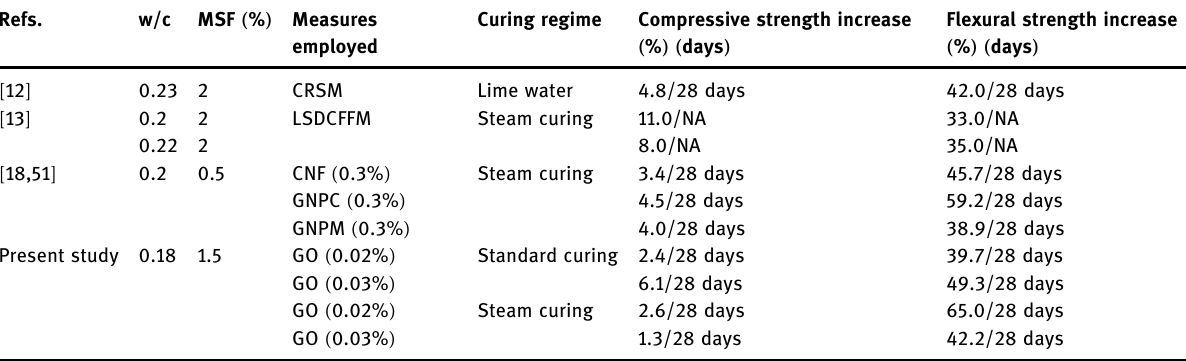
Table 4: Improvement in compressive and fl exural strengths of UHPC*